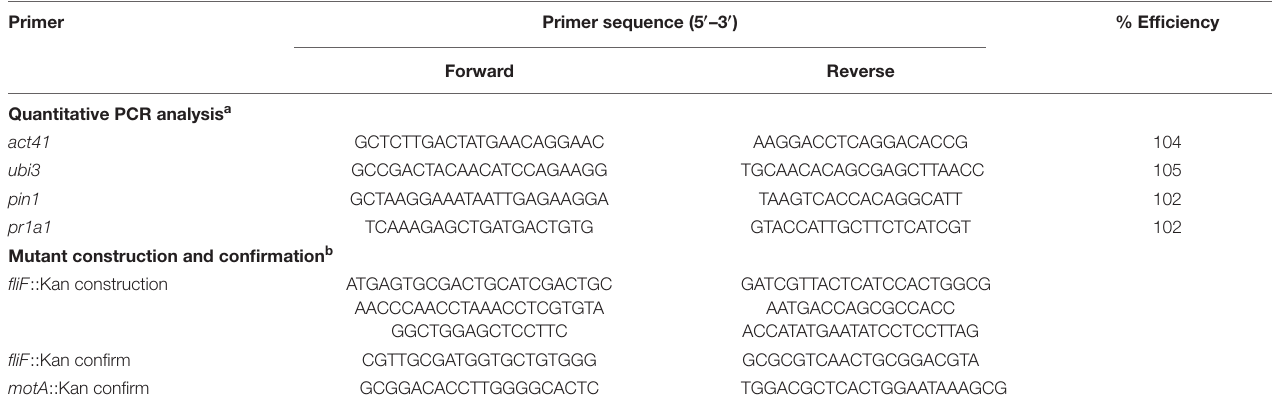
TABLE 2 | List of primers. Primer Primer sequence (5 (cid:48) –3 (cid:48)